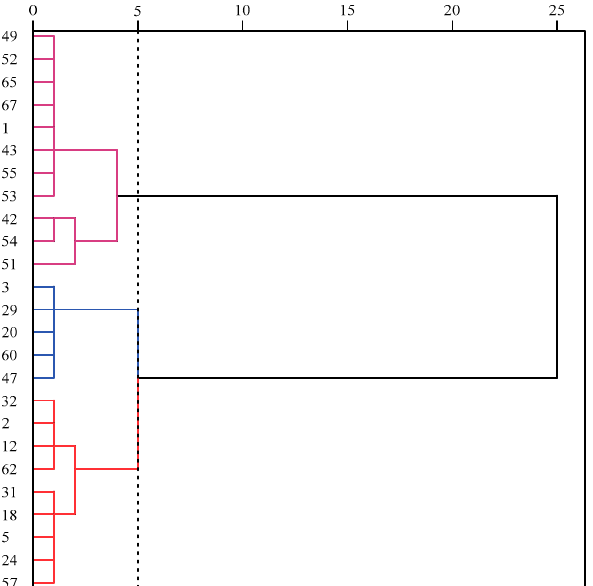
Figure 2. Cluster analysis of 25 varieties at seedling stage in 2019. At a euclidean distances of 5, the 25 varieties are divided into 3 categories, with one color representing one category.